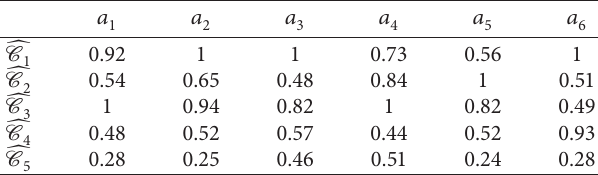
Table 1: Decision-making matrix F with fuzzy information.